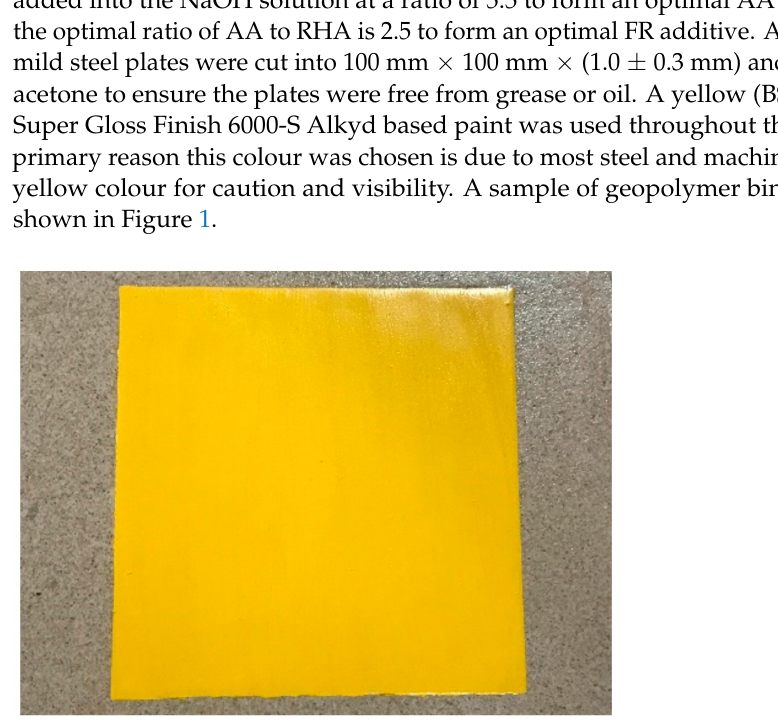
Figure 1. Geopolymer binder hybrid paint coating